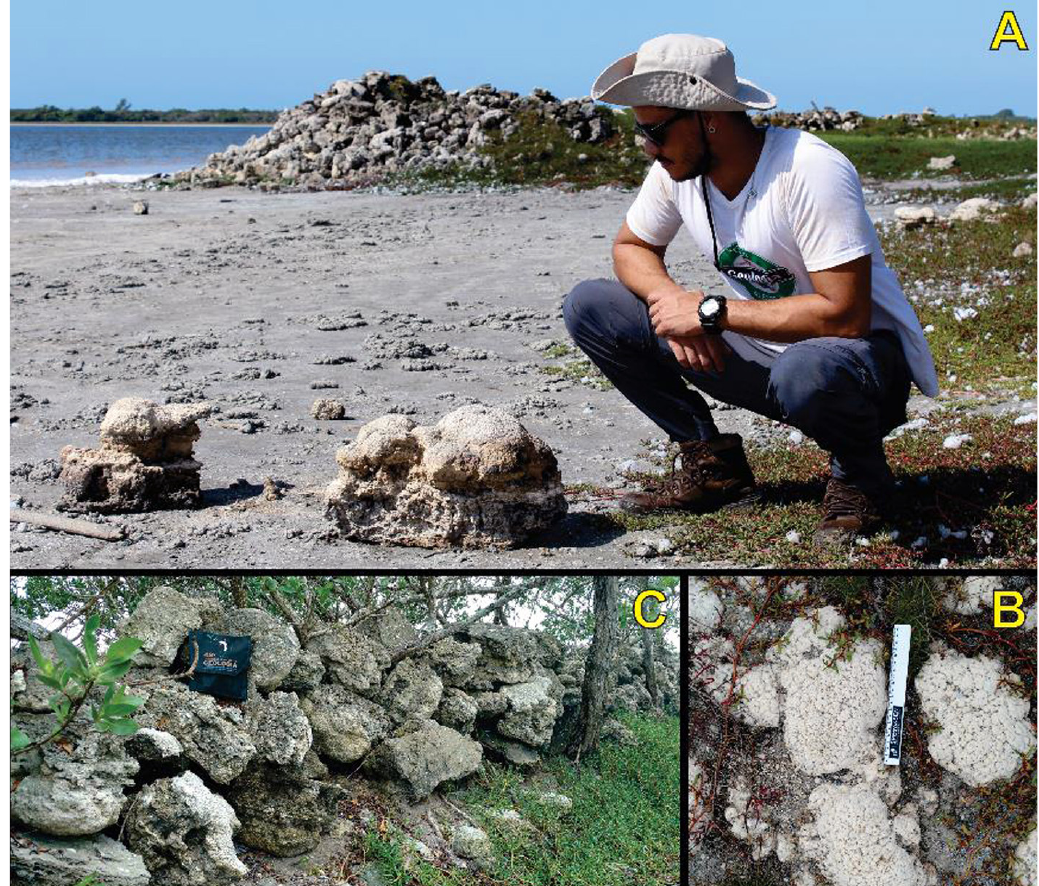
Figure 4 - Exposure of large domal stromatolites. A) Stromatolite in life position and, in the background, piled rounded heads; B) Rounded heads piled up to form fences; C) Aerial view of buried stromatolites (Adapted from Silva 2018).